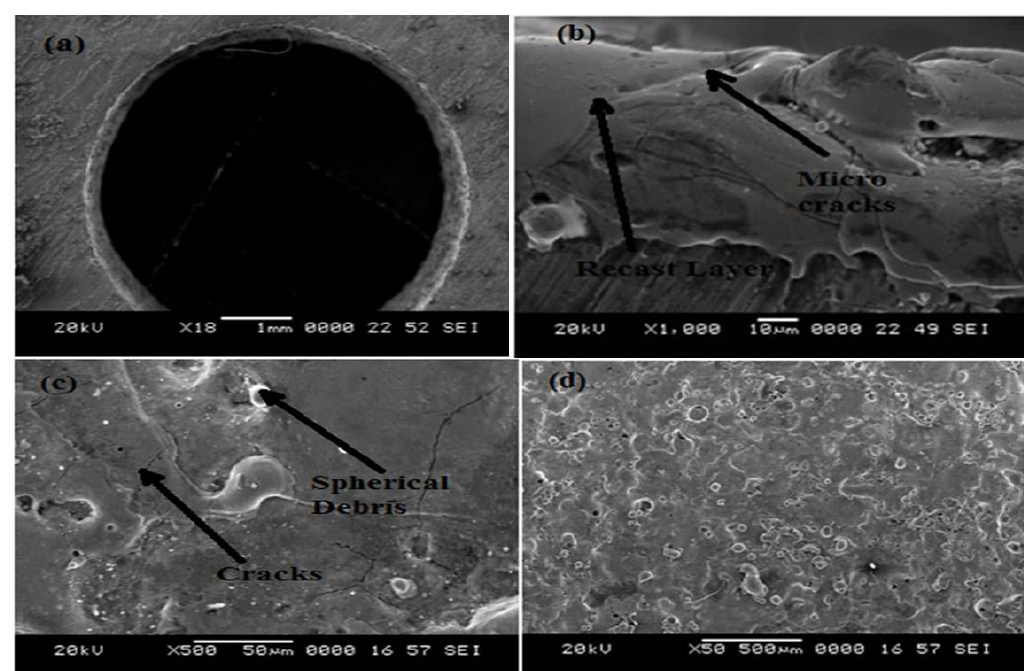
Figure 10: SEM micrograph: Exp No. 8 at T on = 30 µ s; T off = 30 µ s; I p = 9